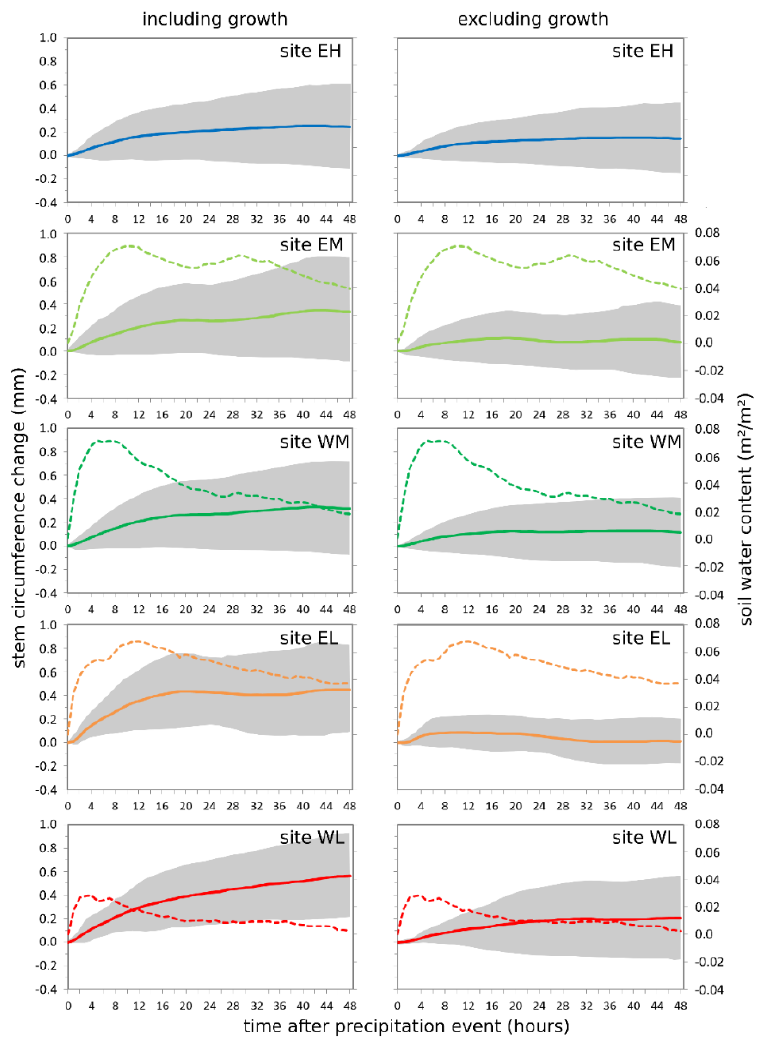
Figure 4. Mean stem circumference changes (solid lines; grey shaded areas indicate the range expressed as mean ± 1 standard deviation) and change of soil water content (dashed lines) over 48 h after precipitation events per site including ( left column ) and excluding ( right column ) tree growth. Precipitation events are extracted from the time period May 2017 to April 2019. Site codes refer to the east (E) and west (W) sides of Corsica, L, M, and H stand for low-, middle-, and high-elevation sites, respectively. Soil water measurements are not available for site EH.